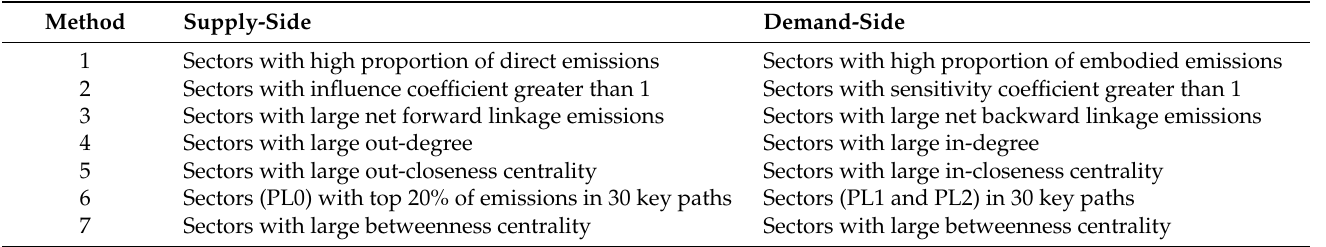
Table 9. The identification methods of key sectors.